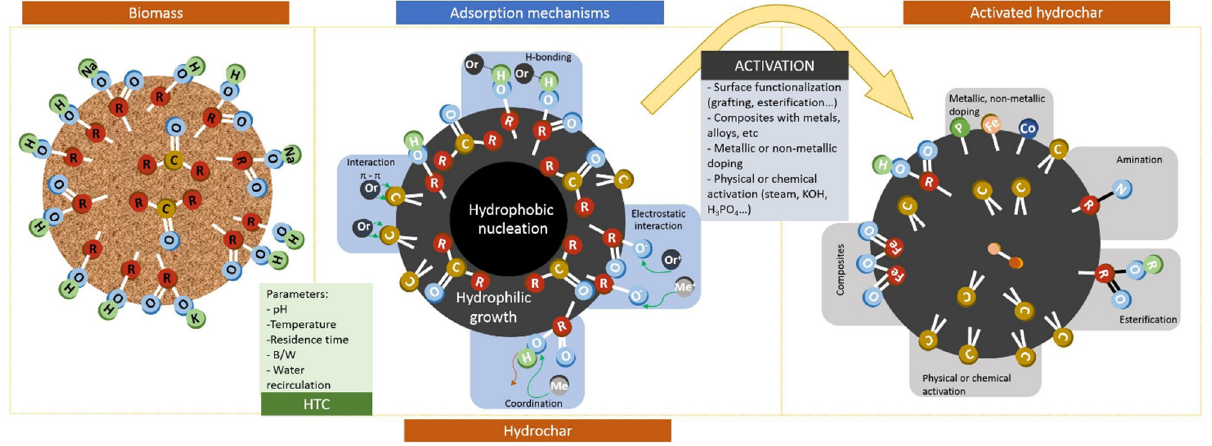
Figure 3. Schematic representation of the formation of hydrochar, its adsorption mechanism, and enhancement method. Reproduced with permission from Fernandez-Sanroman et al. (2021) [98]. Copyright 2021 Elsevier.